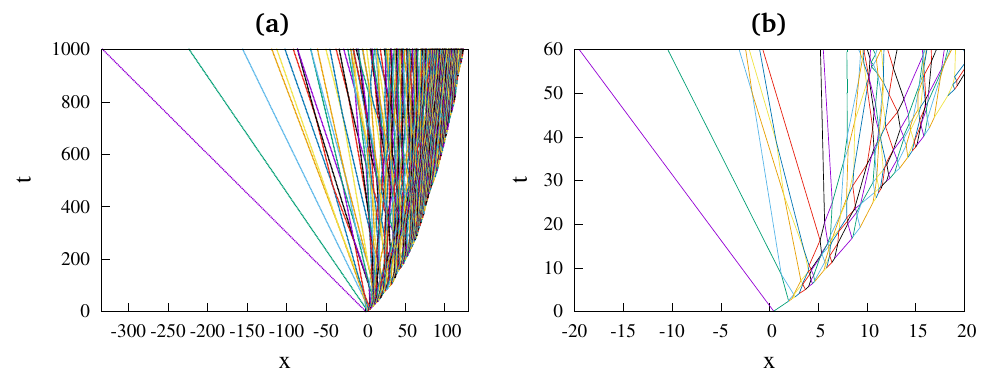
Figure 2: The plot of the space-time trajectories of moving particles of a typical real- ization of a splash in a one-dimensional gas at (a) long and (b) short times. Notice that at the left end we see a fan of particles moving ballistically, while the position of the right-most moving particle (the shock position) evolves sub-ballistically. In (b) we zoom in to see that the left-most particle undergoes a single collision, the next particle 4 collisions and the third particle 6 collisions before their velocities get